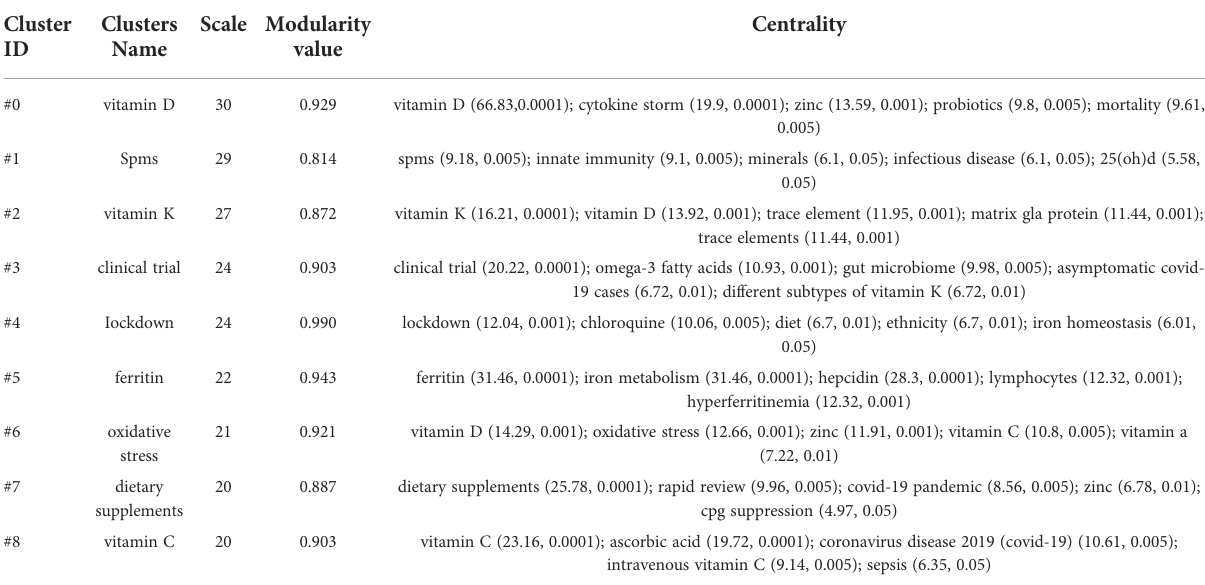
TABLE 9 Top 9 keywords